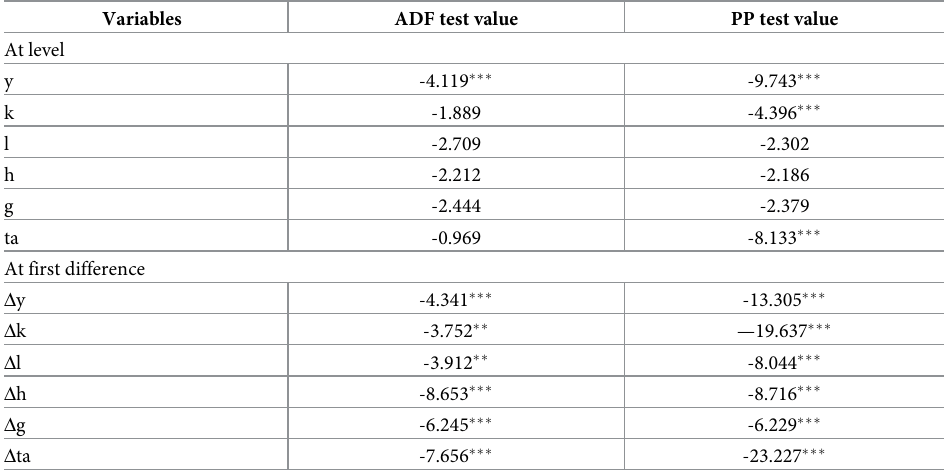
Table 3. Unit root test results.